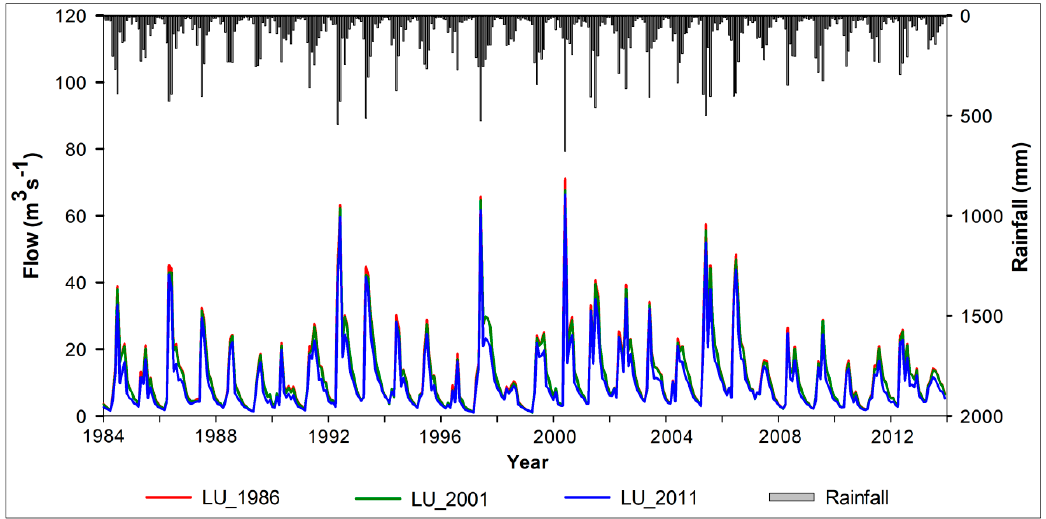
Figure 5. Simulated monthly flow between 1984–2013 for different land use/coverage scenarios (LU_1986, LU_2001, and LU_2011).